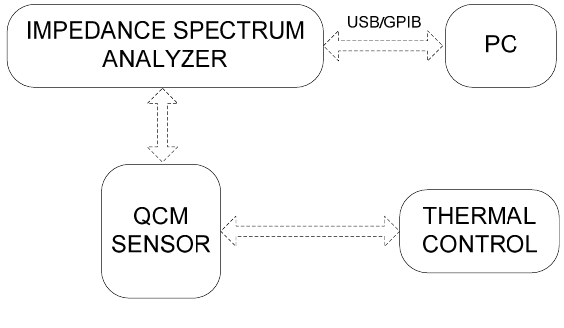
Figure 1. Experimental setup.